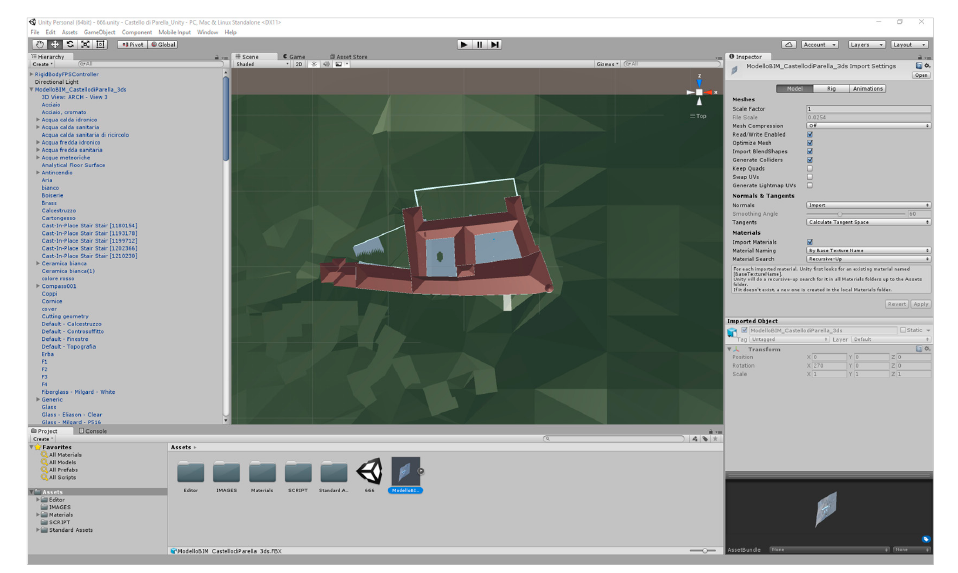
Figure 11. Setting of model properties in Unity 3D.